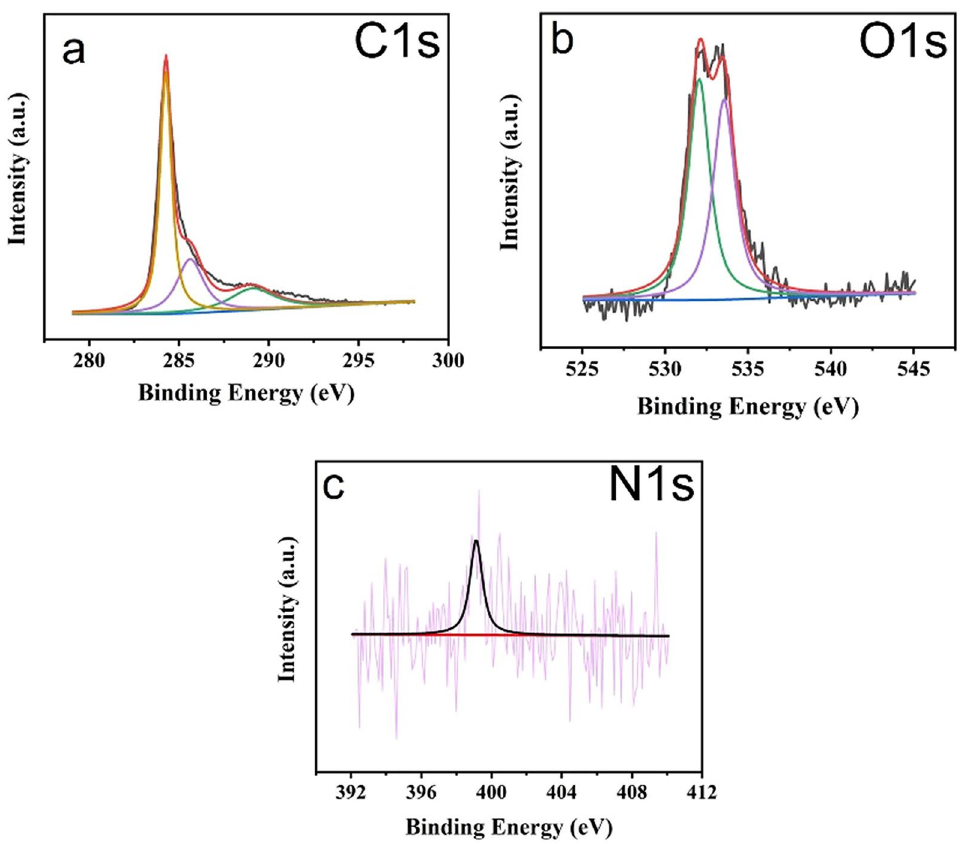
Figure 4. XPS results of the N-doped MWCNT